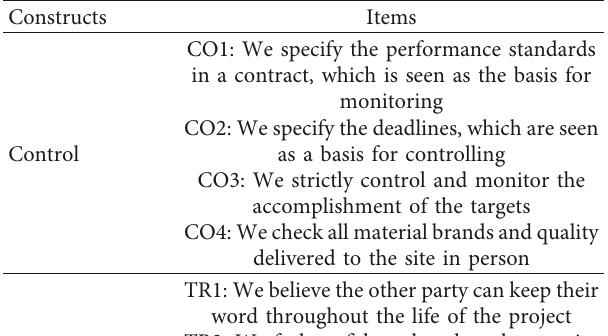
Table 2: Measures of constructs. Constructs Items